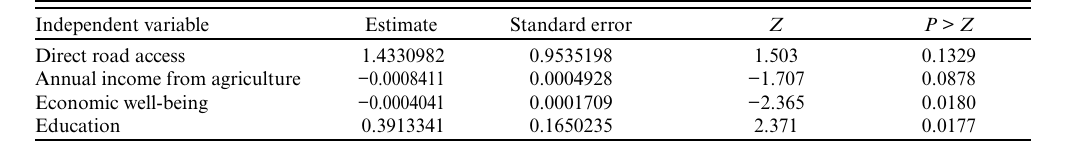
Table 2. Logistic model describing household participation in a logging project in Chico Mendes Extractive Reserve. Dependent variable is household participation in the logging project; N = 37, AIC =